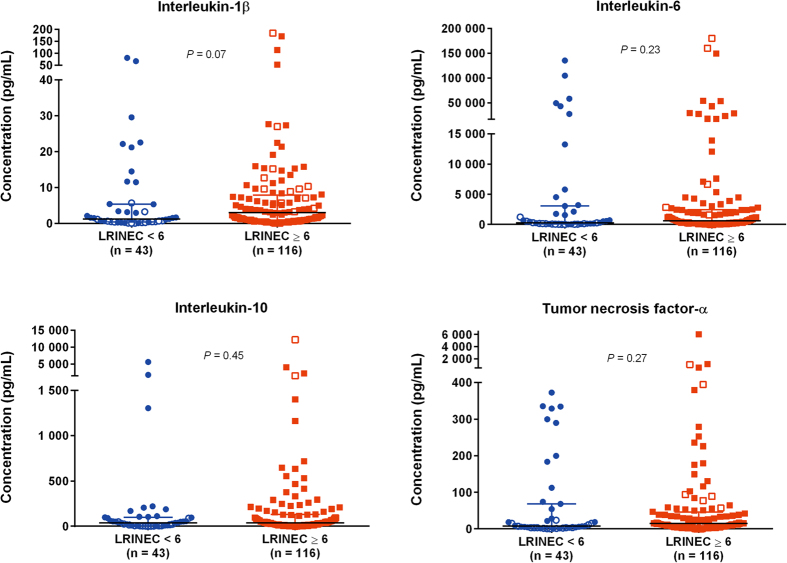
Levels of plasma cytokines on admission according to the LRINEC score in patients with necrotising soft tissue infection.LRINEC, Laboratory Risk Indicator for Necrotising Fasciitis. Filled circles and squares indicate patients with septic shock. Median with interquartile range is illustrated. Comparisons were performed using the Mann-Whitney U test.